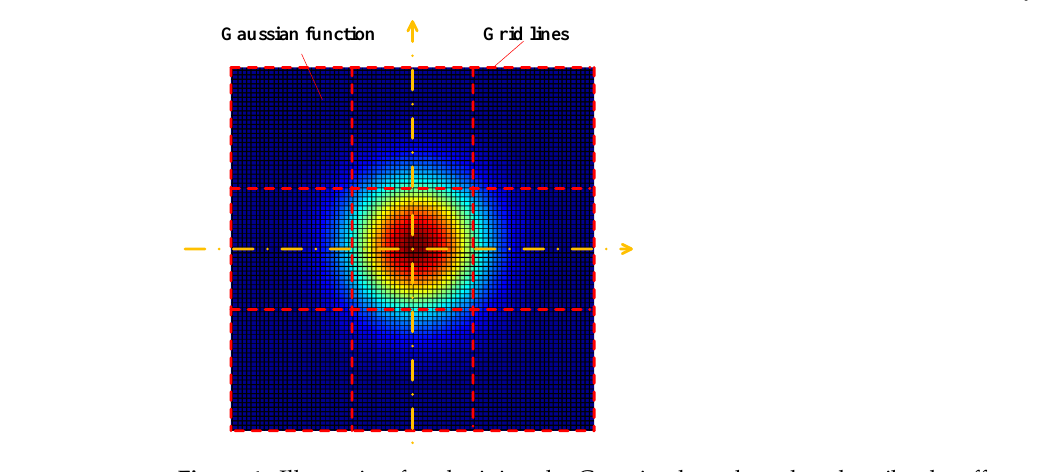
Figure 1. Illustration for obtaining the Gaussian kernel used to describe the effects of jitter. The variance of this Gaussian function should be consistent with the magnitude of jitter.